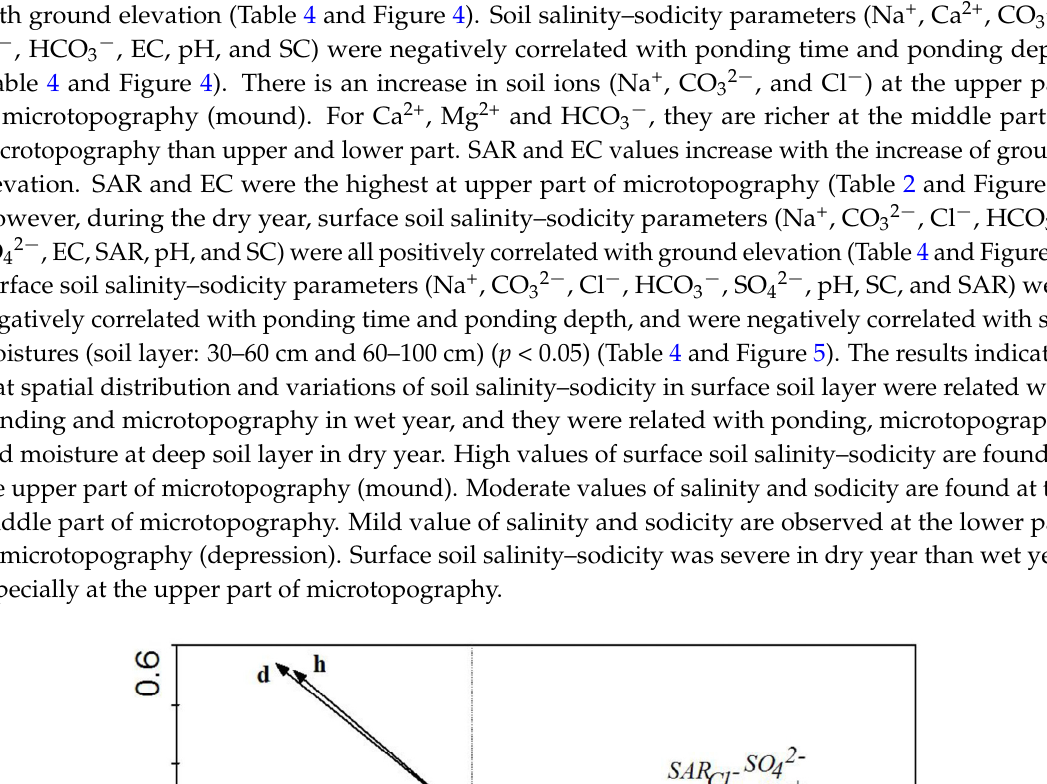
Table 4. Pearson correlation analysis between salinity and sodicity and environmental factors.